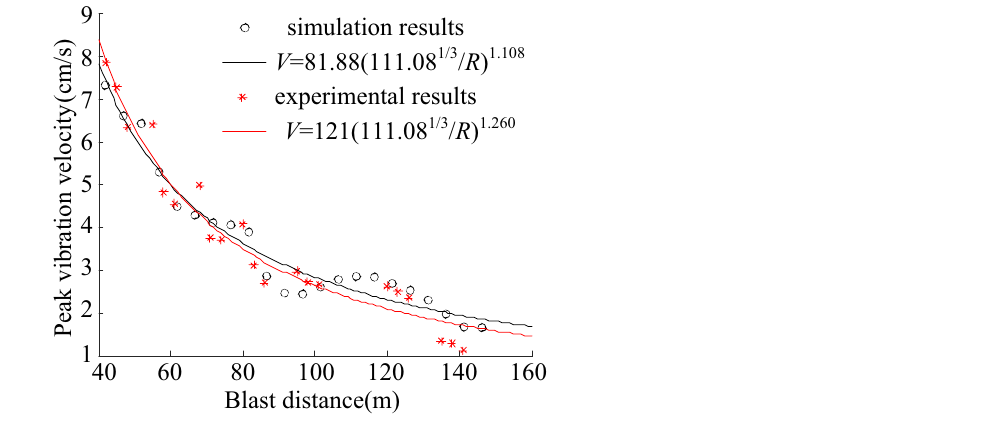
Figure 6. Validation of numerical model.